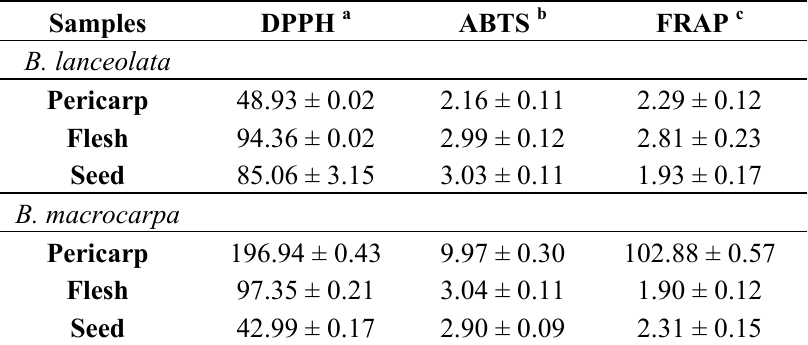
Table 2. Antioxidant activity of B. lanceolata and B. macrocarpa